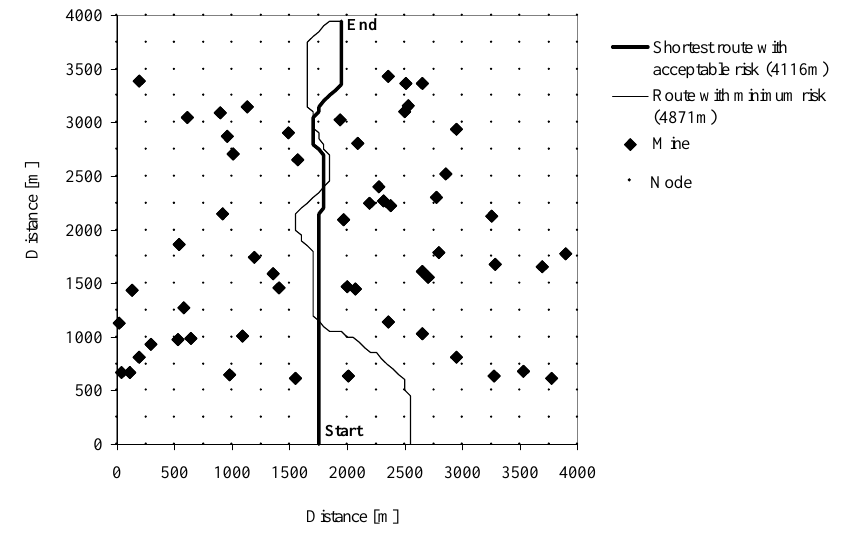
Figure 4: Examples of the routes of minimum risk from the open sea (bottom) into a harbour (top) through a random minefield with safety radius = 200m, grid spacing = 50m (for clarity only every fifth grid point is shown).